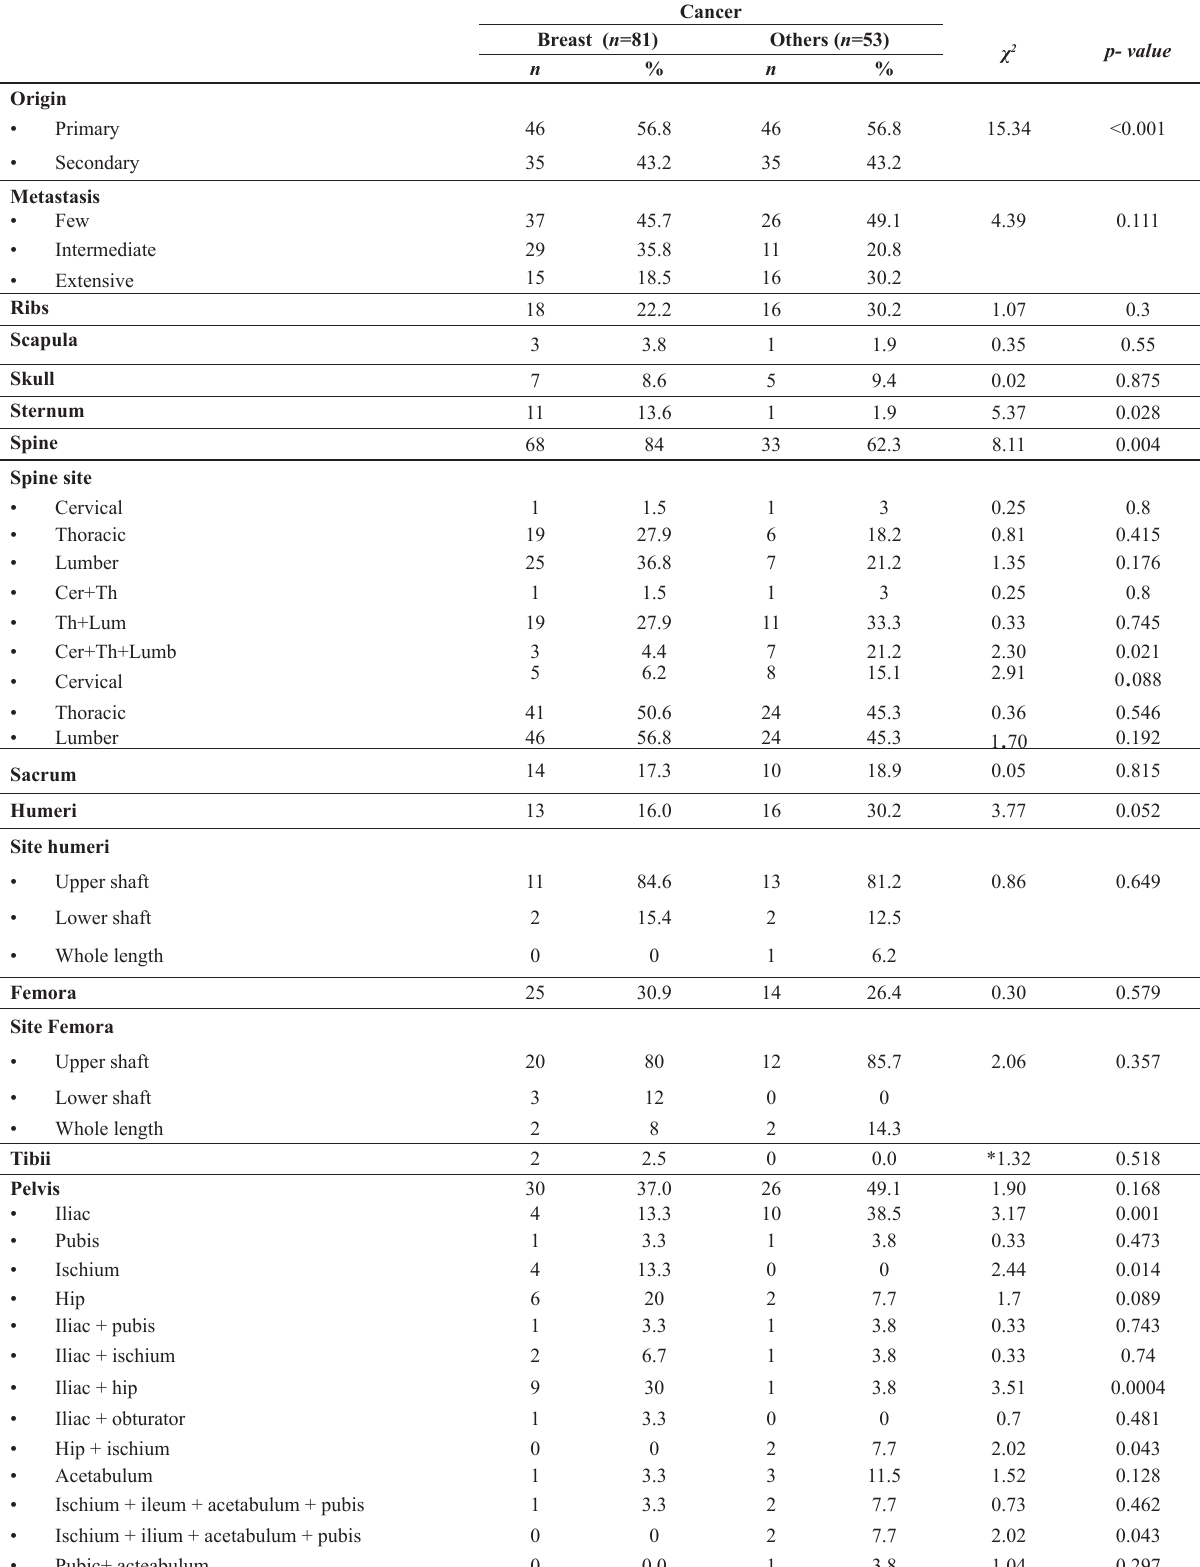
Table 4: Comparison between breast cancer patients and other patients as regard to bone metastases